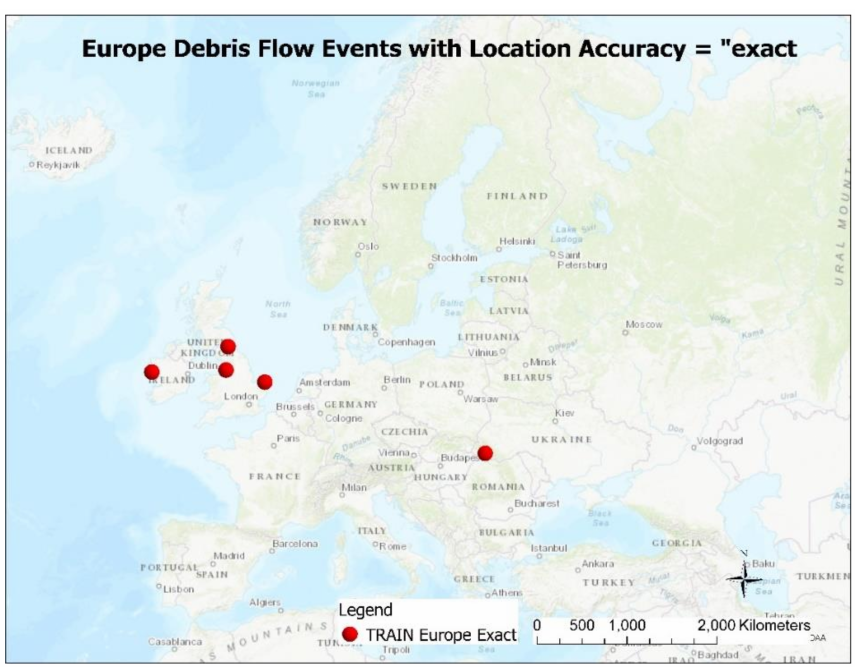
Figure 7. Distribution of the five European debris flow events with a location accuracy of “exact”. Base